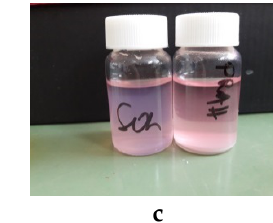
Figure 1. Time dependence of PSD of ( a ) ceria sol and ( b ) ceria powder-containing electrolytic baths after magnetic stirring (MS). PSD of analogous baths after ultrasound stirring (US) is given for comparison (dash lines) [23]. Ceria content was set at 2 g dm − 3 .